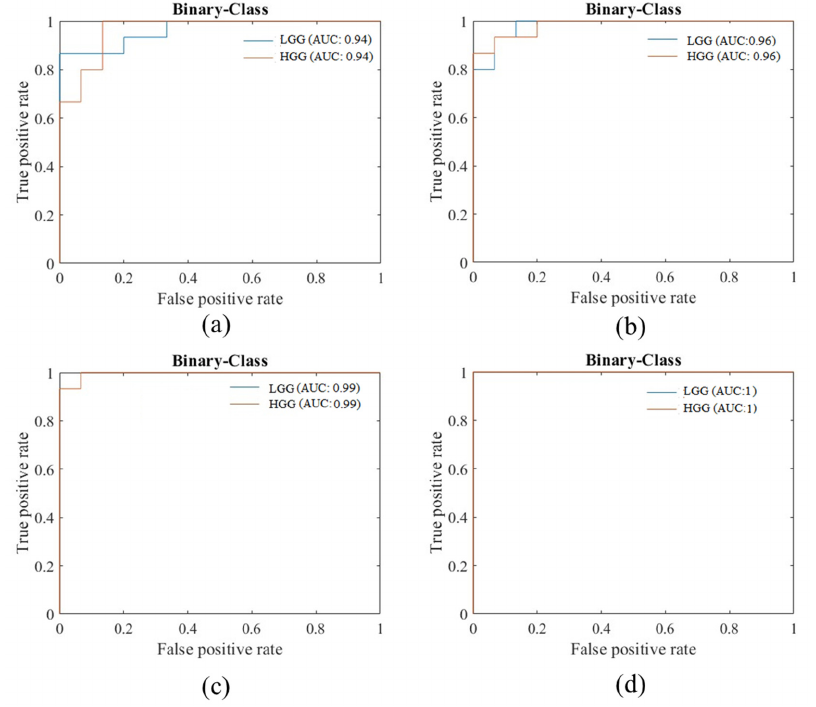
Figure A5. Sample ROC curves of four rounds of training, ( a ) ROC for AUC: 0.94, ( b ) ROC for AUC: 0.96, ( c ) ROC for AUC: 0.99, ( d ) ROC for AUC: 1.